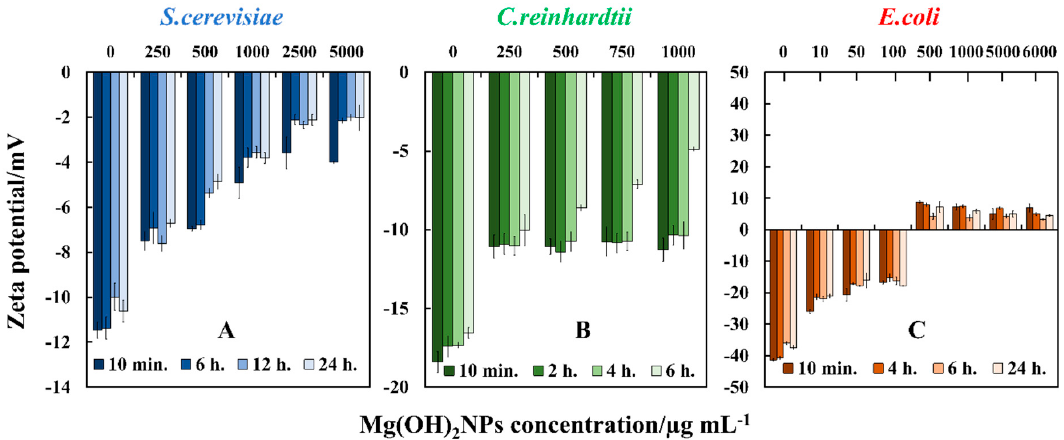
Figure 8. The zeta potential of cells treated with different concentrations of Mg(OH) 2 NP suspensions at various incubation times: ( A ) S.cerevisiae, ( B ) C. reinhardtii, and ( C ) E. coli